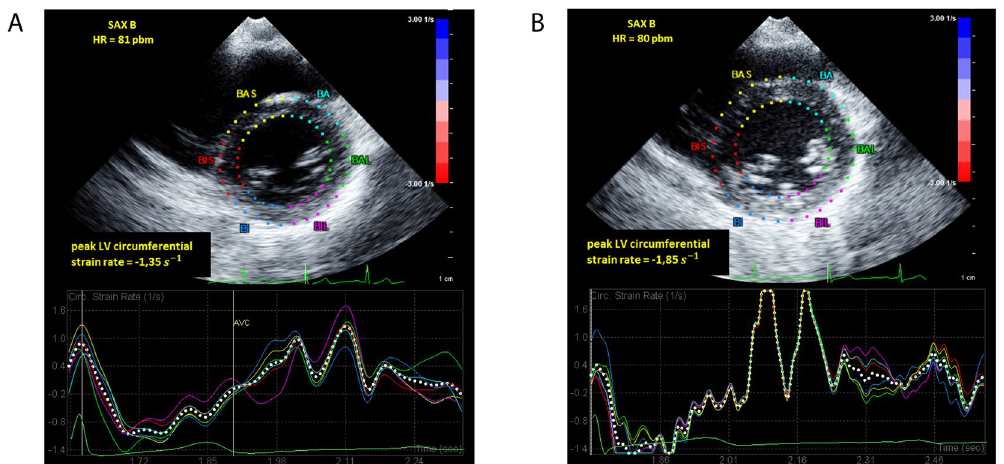
Figure 2. Echocardiographic short axis view derived circumferential strain rate at rest in a patient with active CD ( left ) and a healthy control ( right ). Note the significantly decreased peak LV circumferential strain rate in the child with IBD